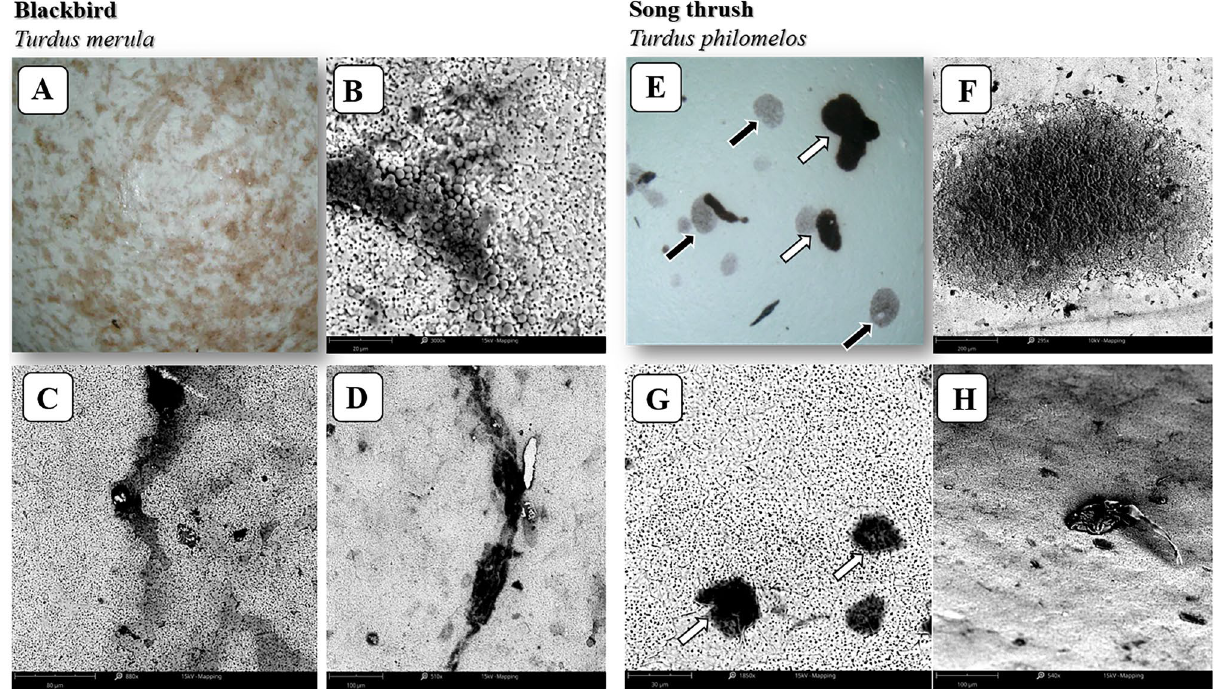
Figure 6. Pigmentation of the eggshells of blackbird and song thrush. Images ( A ) and ( E ) show the actual color of the eggshells. The micrographs show the arrangement and shape of the pigment spots at various magnifications ( B – D : blackbird eggshell, F – H : song thrush eggshell). Black arrows on the surface of the song thrush eggshell indicate deep pigment spots ( E ), and white arrows indicate surface spots ( F and G